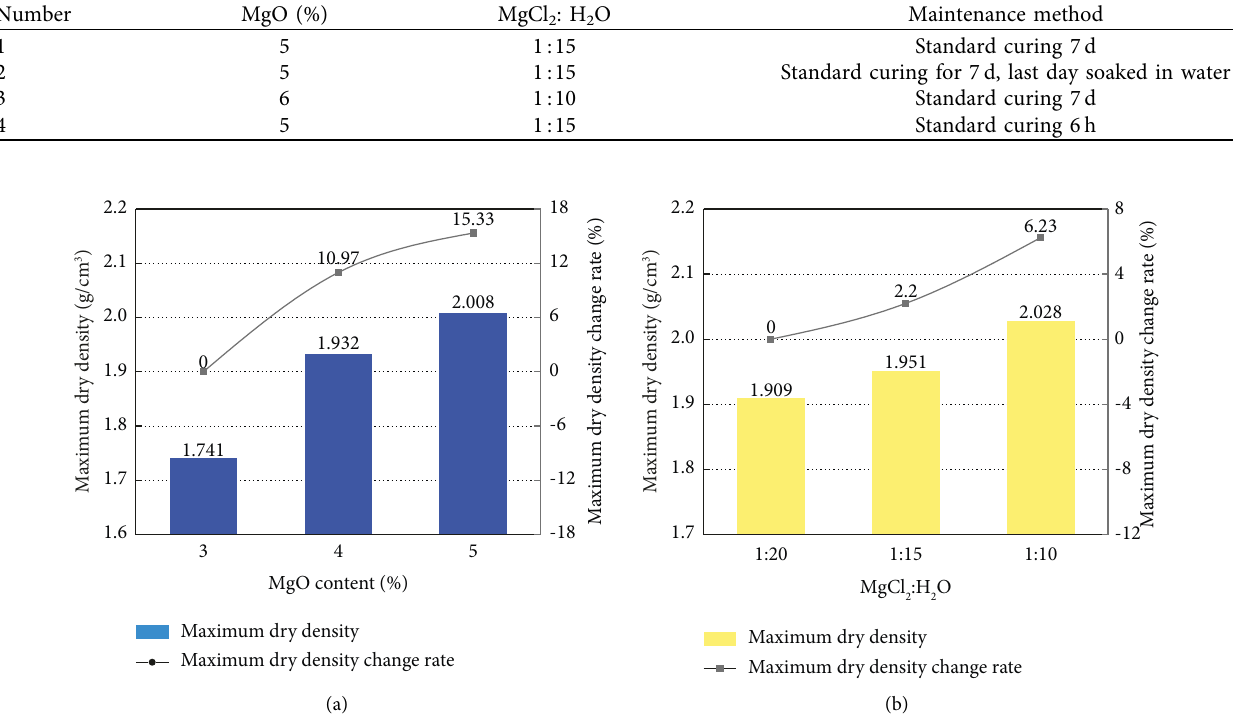
Figure 4: Influence of raw material ratio on the maximum dry density of MOC solidified soil. (a) Different MgO contents. (b) Different ratios of MgCl 2 to H 2 O.